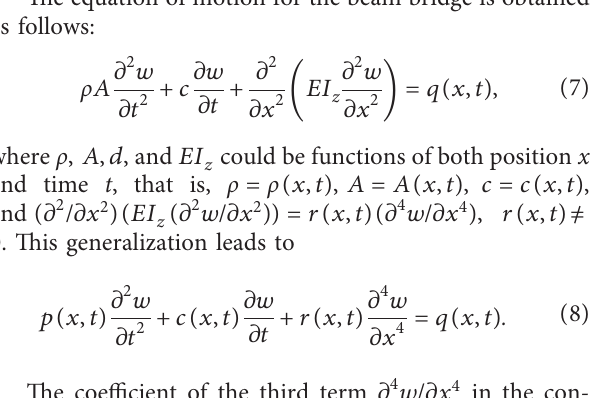
Figure 3: Discretization schema of the beam as lumped